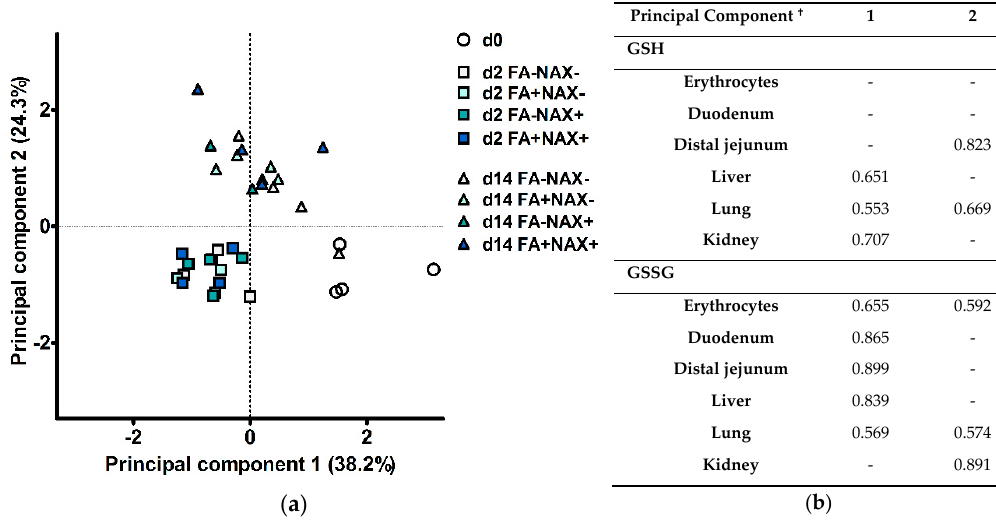
Figure 6. Principal component analysis of glutathione (GSH) and glutathione disulfide (GSSG) concentrations in six different tissues of piglets at 0d, 2d, and 14d post-weaning, either ad libitum fed (FA − ) or fasted (FA + ) the first 2d post-weaning, and either provided standard drinking water (NAC − ) or water supplemented with 200 mg / L N -acetyl cysteine (NAC + ) during the first 14d post-weaning: ( a ) Scores plot representing the 36 individual piglets in the multivariate space of the first two principal components. Animals can be visually clustered according to day post-weaning (d0, d2, or d14). ( b ) Loadings of the two major principal components. These loadings indicate the correlation (positive or negative) between the original variables and the principal component. Squared factor loadings indicate the percentage of variance in an original variable explained by the principal component. † Only correlations with |r|> 0.5 are indicated.